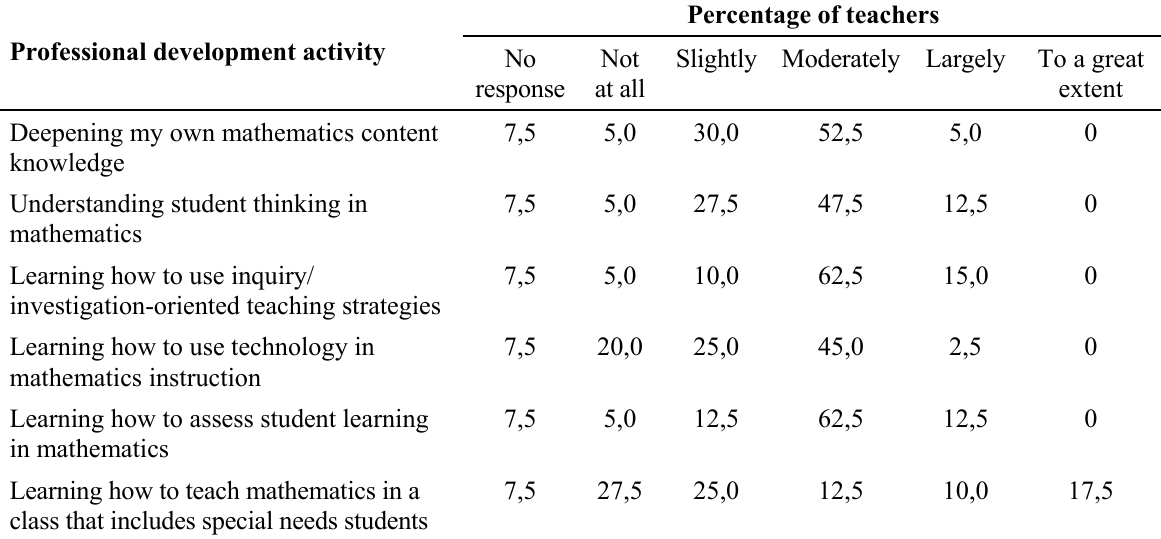
Table 8 : Emphasis of teachers’ professional development activities (N = 40)